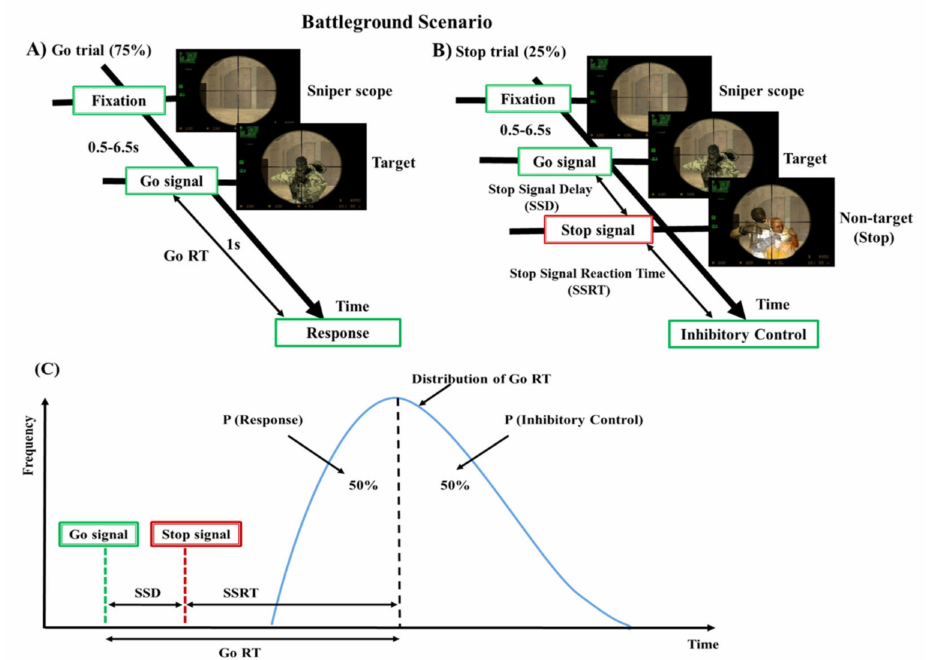
Figure 1. Design of stop signal task: ( A ) go trial and ( B ) stop trial under battleground scenario. Each subject performed go trials (75%) and stop trials (25%) according to the stimuli presented in the battleground scenario. ( C ) The theoretical model of the stop-signal task and where P is the probability of responding to the